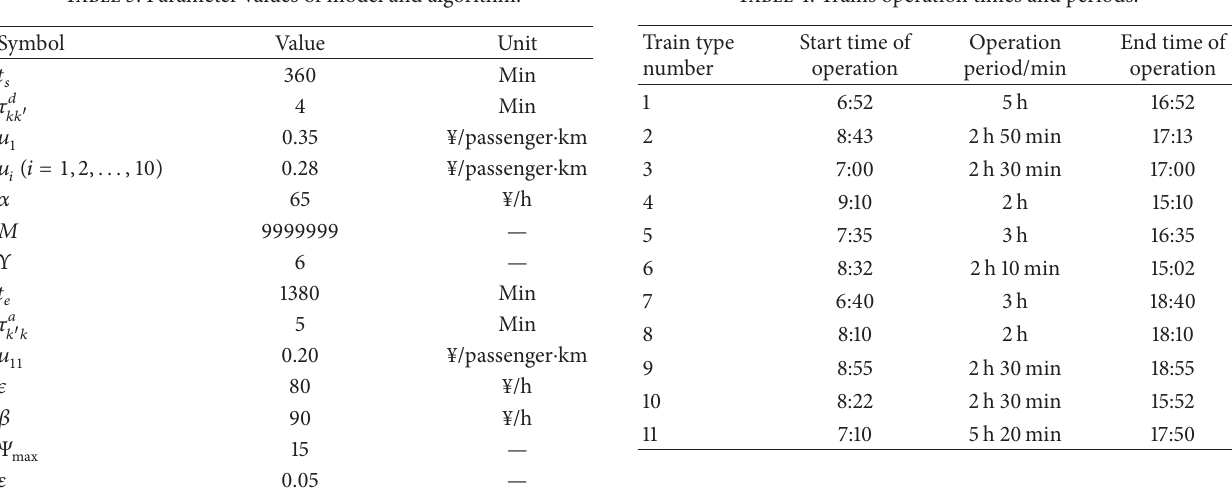
Figure 5: The multiperiod mixed train diagram with periods of the multiples of 10min. Table 3: Parameter values of model and algorithm. Table 4: Trains operation times and